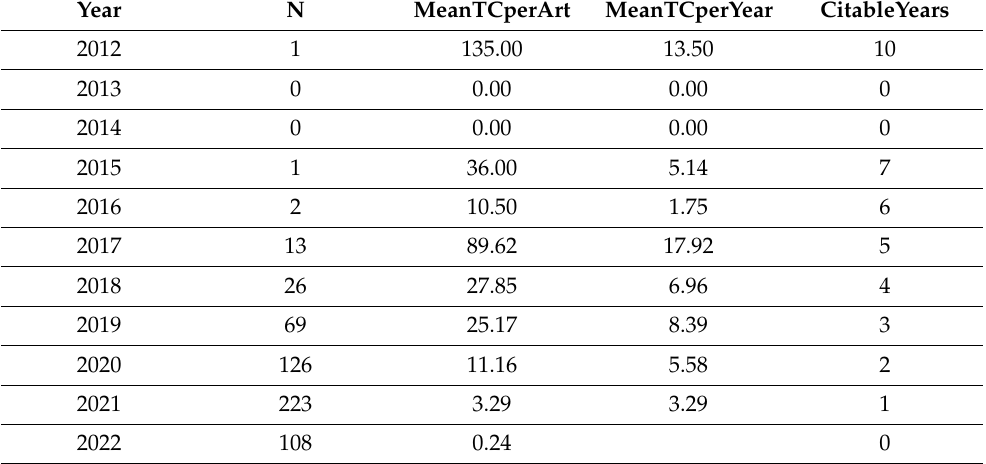
Table 2. Annual total citation per